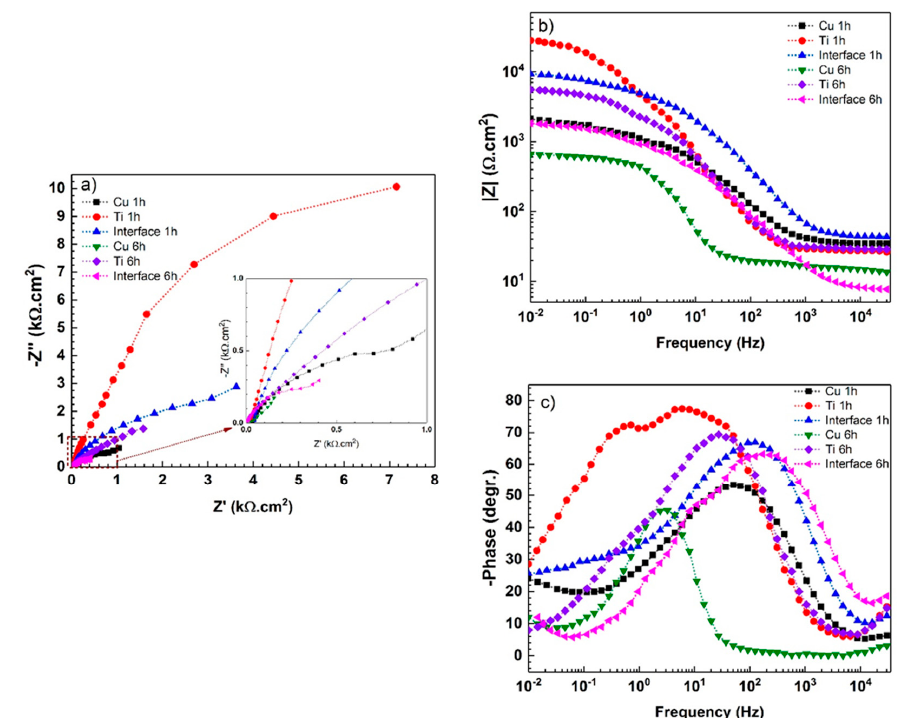
Figure 8. ( a ) Nyquist, ( b ) Bode |Z| and ( c ) Bode-phase diagrams resulting from electrochemical impedance spectroscopy of Ti, Cu and weld interface in 3.5 wt.% NaCl solution after 1 h and 6 h immersion around E ocp .